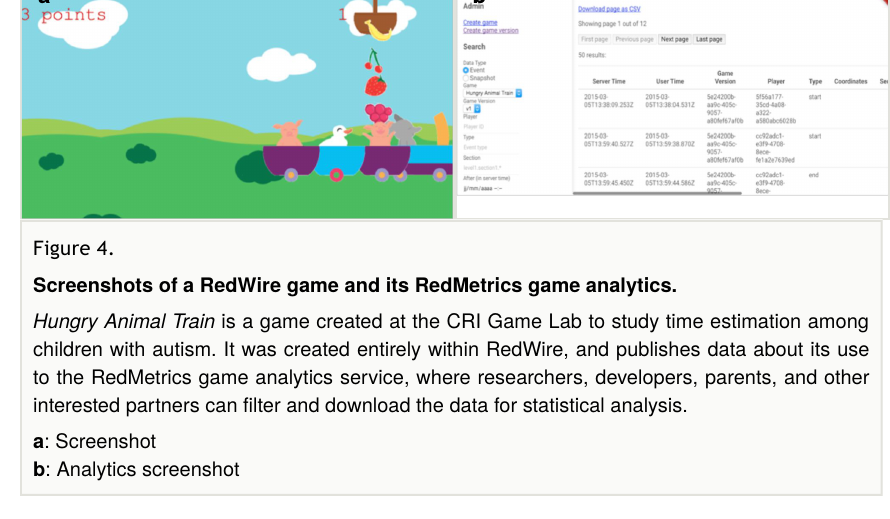
platform it is developed on.